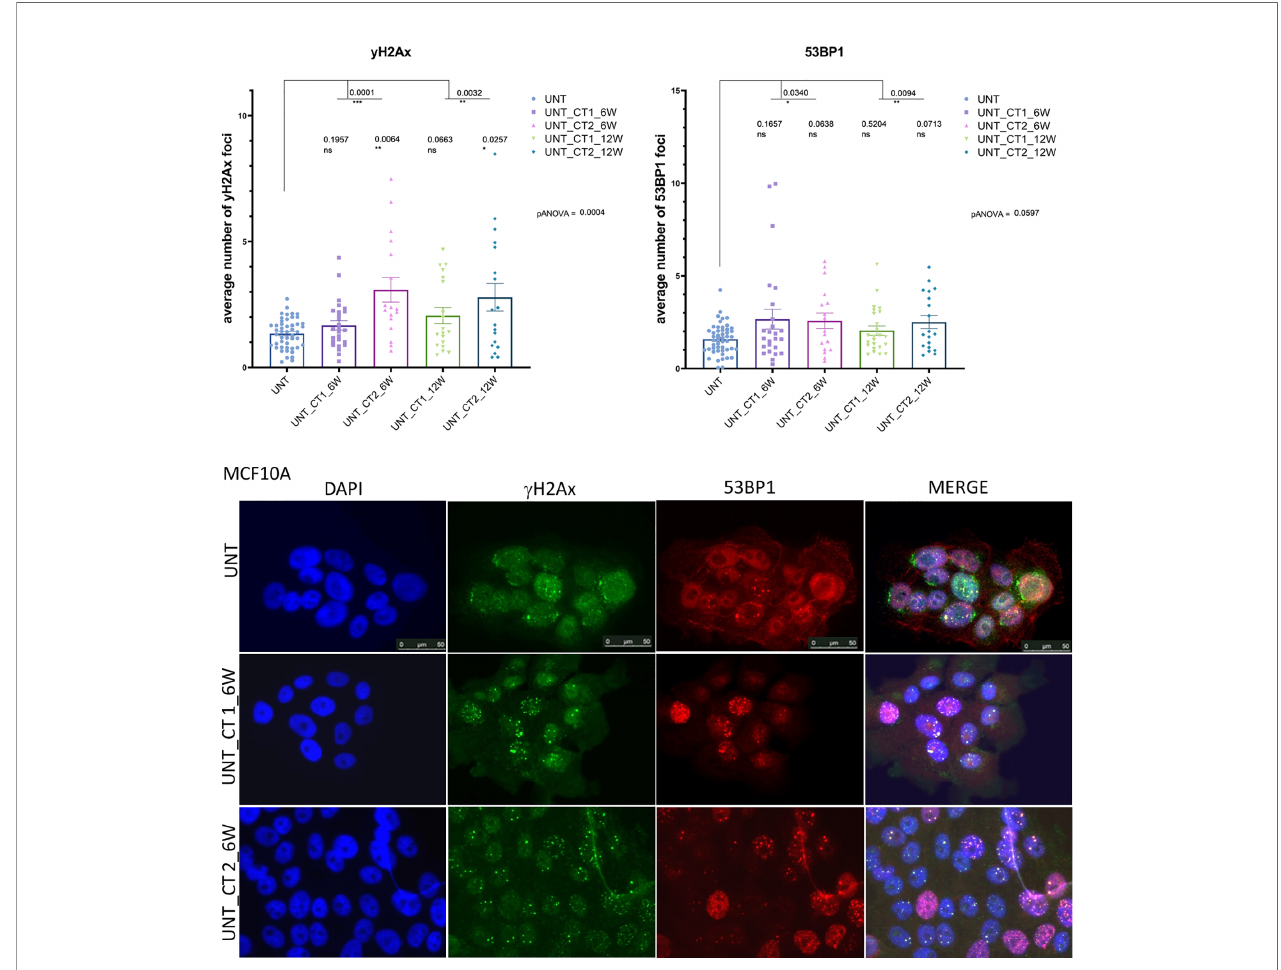
FIGURE 3 | Immunocytochemical analysis of background persisting foci number after repeated CT scans in MCF10A cells (replication study). Upper Panel: Evaluation of g H2AX foci (left) and 53P1 foci (right) from repeated experimental settings in 6 and 12 weeks intervals after systematic diagnostic CT scans with 20 mGy per round (in total three rounds) using conventional fl uorescence microscopy (Leica DMI6000B). Data are presented as bar plots of average number of foci (+/ − SEM) per cell. Each data point represents randomized counting area of slide from two independent experiments (biological replicates) and two technical replicates (UNT, untreated values with included “ age-matched ” controls; CT 1, cells, which went once through the CT and were further cultured for 6 or 12 weeks, respectively; CT 2, cells, which went twice through the CT after 6 or 12 weeks; ns, not signi fi cant; SEM, standard error of the mean). Lower panel: Example of H2AX foci (green) and 53BP1 foci (red) double immunostaining. DNA is counterstained with DAPI (UNT, untreated value “ age-matched ” to UNT_CT 2; UNT_CT 1, cells were cultured 6 weeks after the 1st round of computed tomography; UNT_CT 2, cells were further cultured for 6 weeks after the second subsequent diagnostic CT and went through two CT rounds). *P ≤ 0.05 , **P ≤ 0.01, ***P ≤